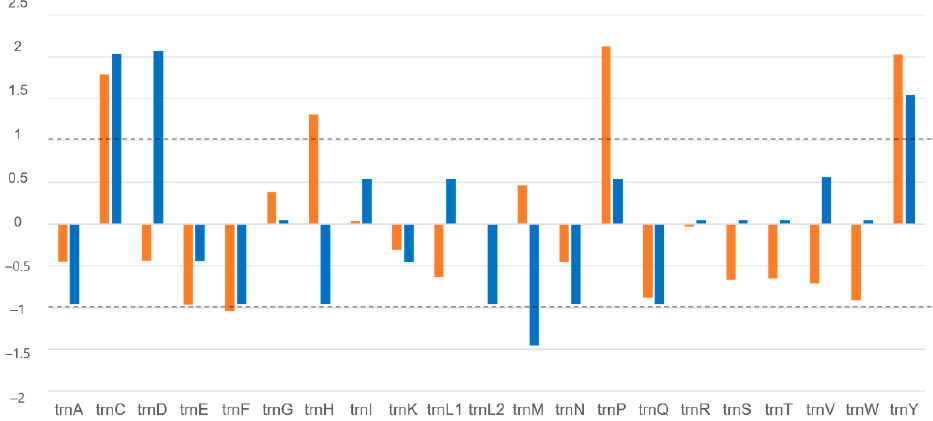
Figure 4. The total mutation rate in each tRNA gene in all cichlids compared to haplotilapiine lineage. Every two columns represent one of the tRNA genes. Orange color represents tRNAs in cichlid species, while blue represents the haplotilapiine species. Numbers above the z-score standard limits (dotted line; +1 or − 1) represent the extreme hypervariable tRNA genes, while those below represent the extreme hypovariable tRNA genes. The trnS is trnS UGA , trnL1 is trn UAA and the trnL2 is trnL UAG .